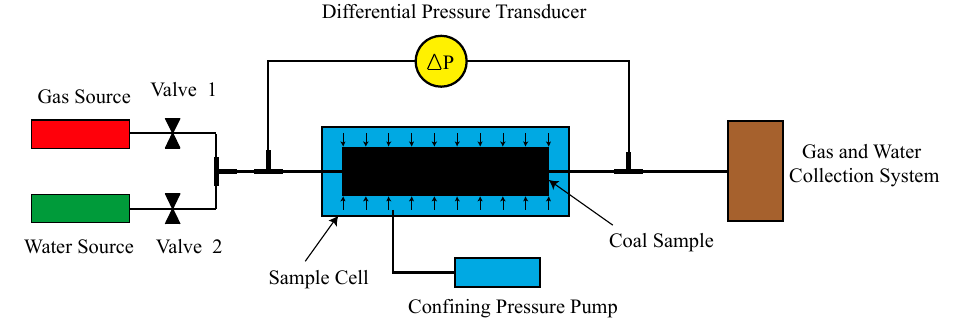
Figure 4. The principle of steady-state measurement.